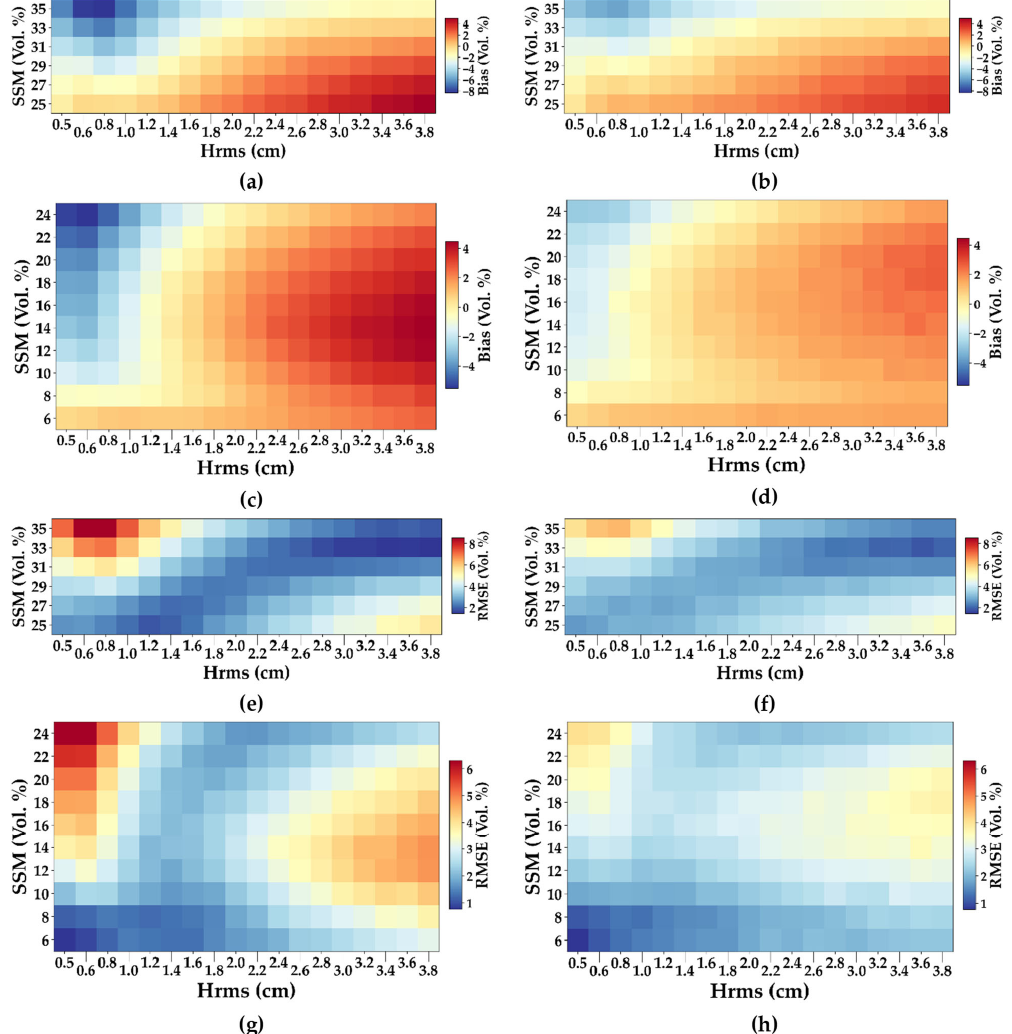
Figure 11. Bias (estimated SSM − reference SSM) and RMSE as a function of reference Hrms and SSM using simulated C-band data. ( a , e ) NN with a priori information on SSM for very wet soils without Hrms in input (NN11); ( b , f ) NN with a priori information on SSM for very wet soils with noisy Hrms in input (NN15); ( c , g ) NN with a priori information on SSM for dry to slightly wet soils without Hrms in input (NN6); ( d , h ) NN with a priori information on SSM for dry to slightly wet soils with noisy Hrms in input (NN10).